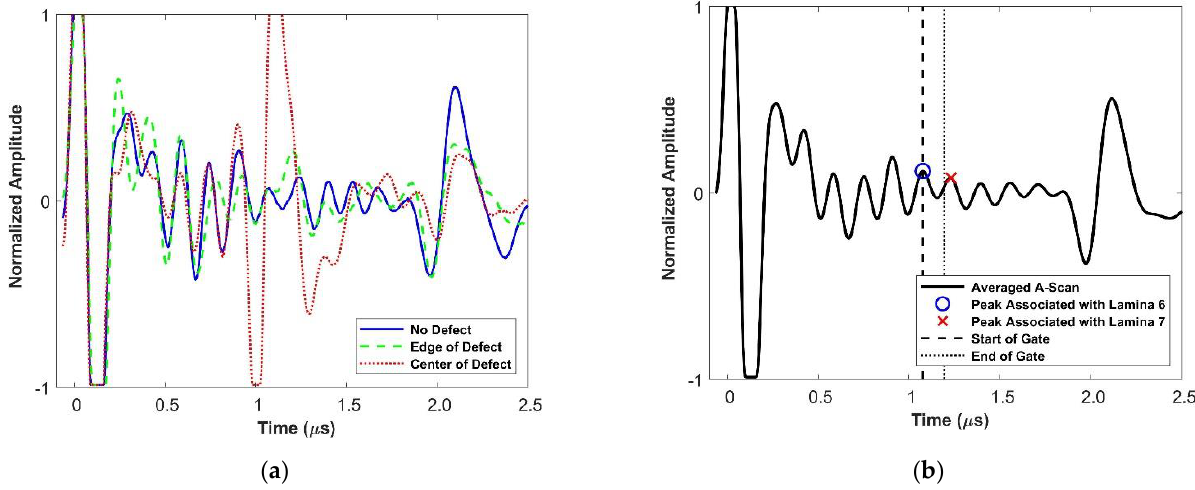
Figure 3. ( a ) Comparison of a-scans over a region with a defect and one that is defect free ( b ) Averaged a-scan used to determine proper depth for the start of a c-scan gate. Average is taken over all a-scans from the sample.